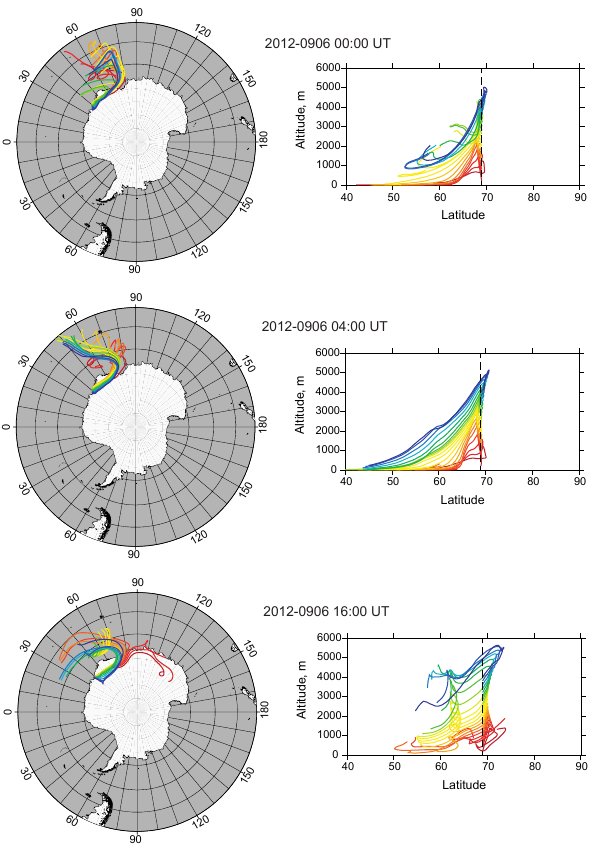
Fig. 6. Examples of 5-day backward trajectory at 00:00UT on 6 September, at 04:00UT on 6 September, and at 16:00UT on 6 September. Dashed line represents latitude of Syowa Station (69 ◦ S). Trajectories are color coded to correspond to initial height over Syowa